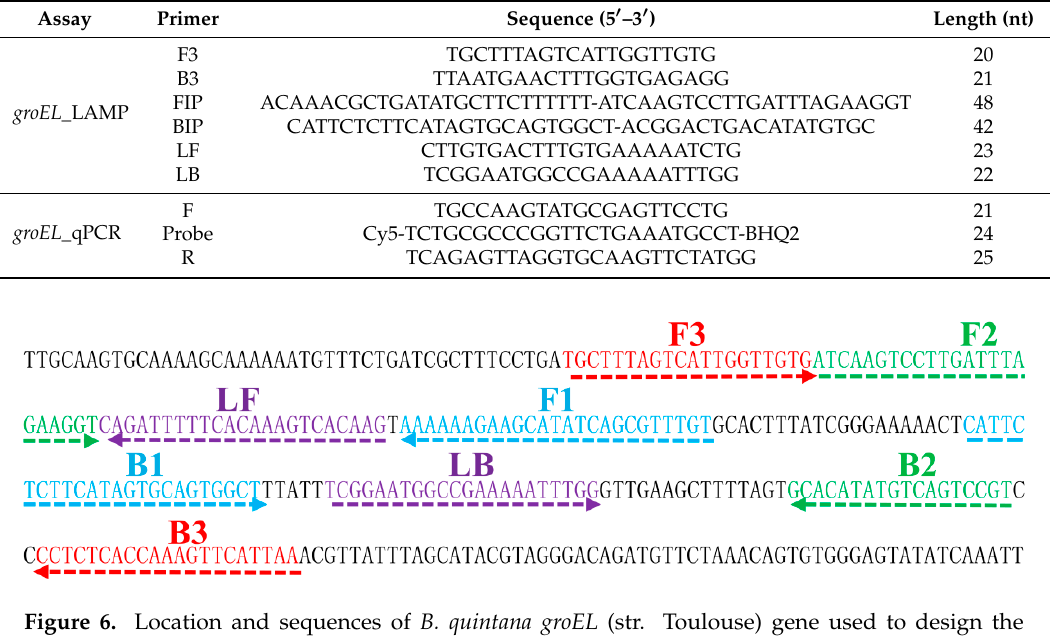
Table 4. LAMP and qPCR primers used in this study.